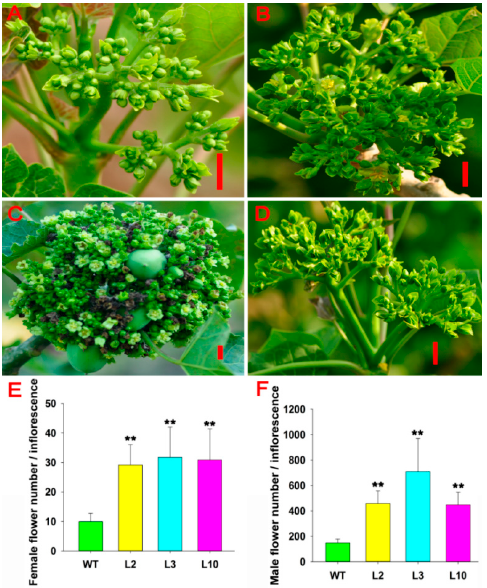
Figure 5. Number of flowers per inflorescence was increased in the JcDAD1 -RNAi transgenic plants. ( A − D ) Inflorescences of wild-type (WT) plants ( A ), and inflorescences of transgenic lines L2 ( B ), L3 ( C ), and L10 ( D ); bars = 1.0 cm. ( E , F ) Comparison of female ( E ) and male ( F ) flower number per inflorescence in the transgenic lines (L2, L3 and L10) with those in the WT plants, n ≥ 8. Error bars represent the standard deviations. Student’s t -test was performed to analyze significant differences. ** Extremely significant difference ( p < 0.01).